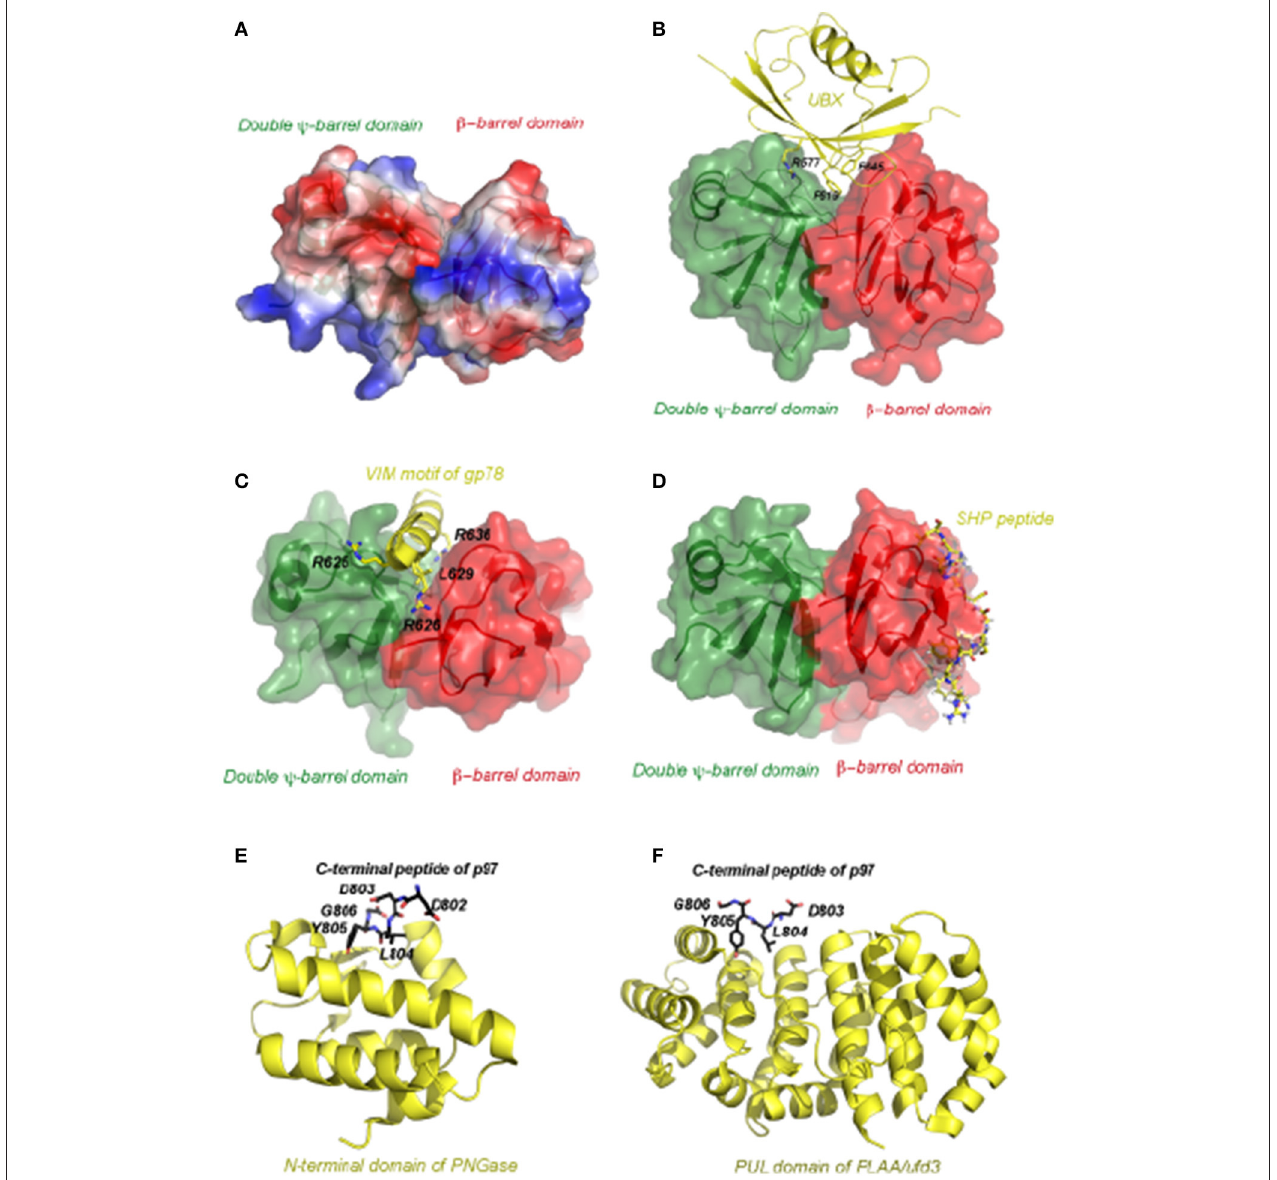
FIGURE 4 | The atomic representation of p97 in complex with various representative interacting motifs. (A) The structure of the N-terminal domain of p97 shown as electrostatic potential surface. The positive potential is in blue, negative in red and neutral in white. (B) Structure of the p97 N-domain in complex with the UBX domain of FAF1 (PDB:3QC8). The N-domain, depicted as a molecular surface overlaid to a ribbon representation, has the N-terminal double Y-barrel domain colored green and C-terminal β -barrel domain colored red. The UBX domain of FAF1 is depicted as ribbon diagram in yellow. Critical residues for interaction are shown as ball-and-stick models and labeled. (C) Structure of the p97 N-domain in complex with the VIM motif of gp78 (PDB:3TIW). Here the VIM motif is shown as helix in yellow and its binding to the N-domain is mostly mediated by charged residues. (D) Structure of the p97 N-domain in complex with the Ufd1 derived SHP peptide (PDB:5C1B). Here the SHP peptide is shown as the stick model in yellow and it binds exclusively to the C-terminal β -barrel domain. (E) Structure of the N-terminal domain of PNGase in complex with a C-terminal peptide of p97 (PDB:2HPL). The PNGase N-terminal domain is shown in cartoon representation in yellow. The bound peptide is shown as a stick model with five residues (labeled) seen in the structure. The carbon atoms are colored in black, nitrogen in blue and oxygen in red. (F) Structure of the PUL domain of FLAA/Ufd3 in complex with a C-terminal peptide of p97 (PDB:3EBB). The PLAA PUL domain is shown in cartoon representation in yellow. The bound peptide is shown as a stick model with four residues visible in the structure. The carbon atoms are colored in black, nitrogen in blue and oxygen in red.